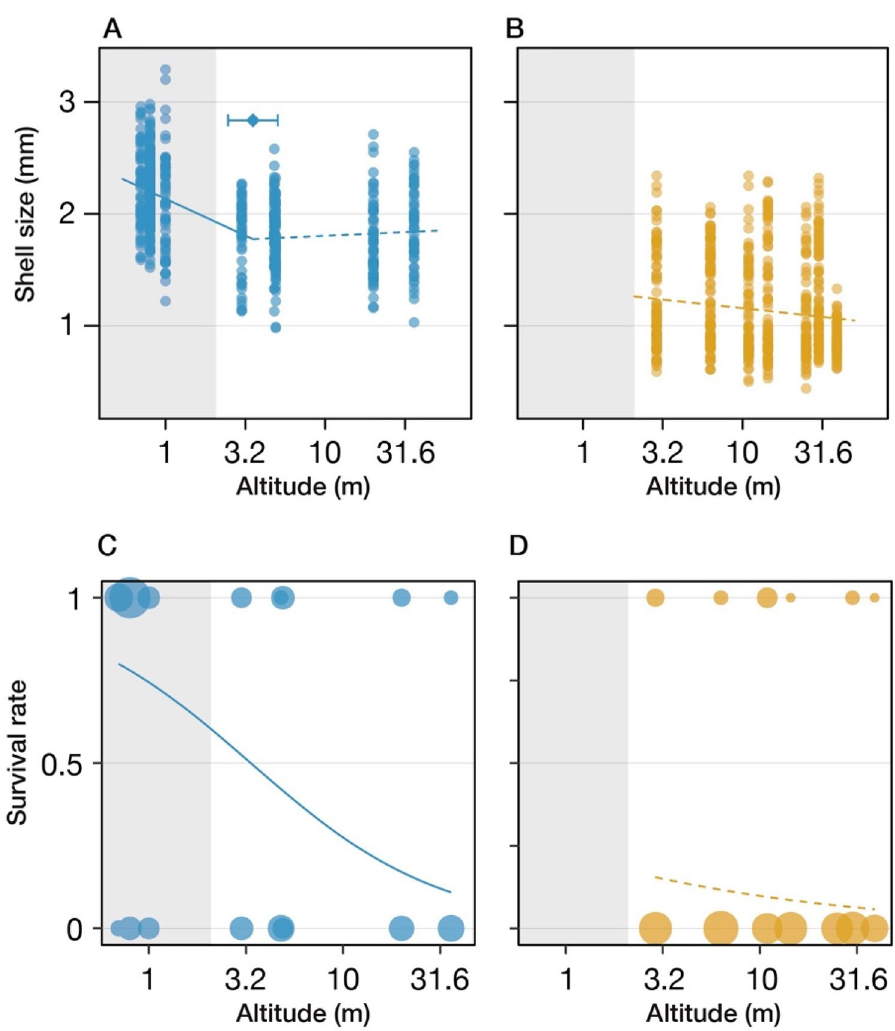
Figure 2. Shell size of juveniles in each population in the gentle ( A ) and steep rivers ( B ). Each line was estimated using a segmented regression method, and the rhombus and whisker represent the significant segmented point and the confidence interval, respectively. The shaded area in each panel indicates the intertidal region in the gentle river (Kiso River). The survival rate of juveniles exposed to 3% saline water in the gentle ( C ) and steep rivers ( D ). The size of each point shows the number of juvenile dead (bottom of each panel) or alive (top of each panel). The curves in each panel were estimated using a generalized linear model, and the line type represents